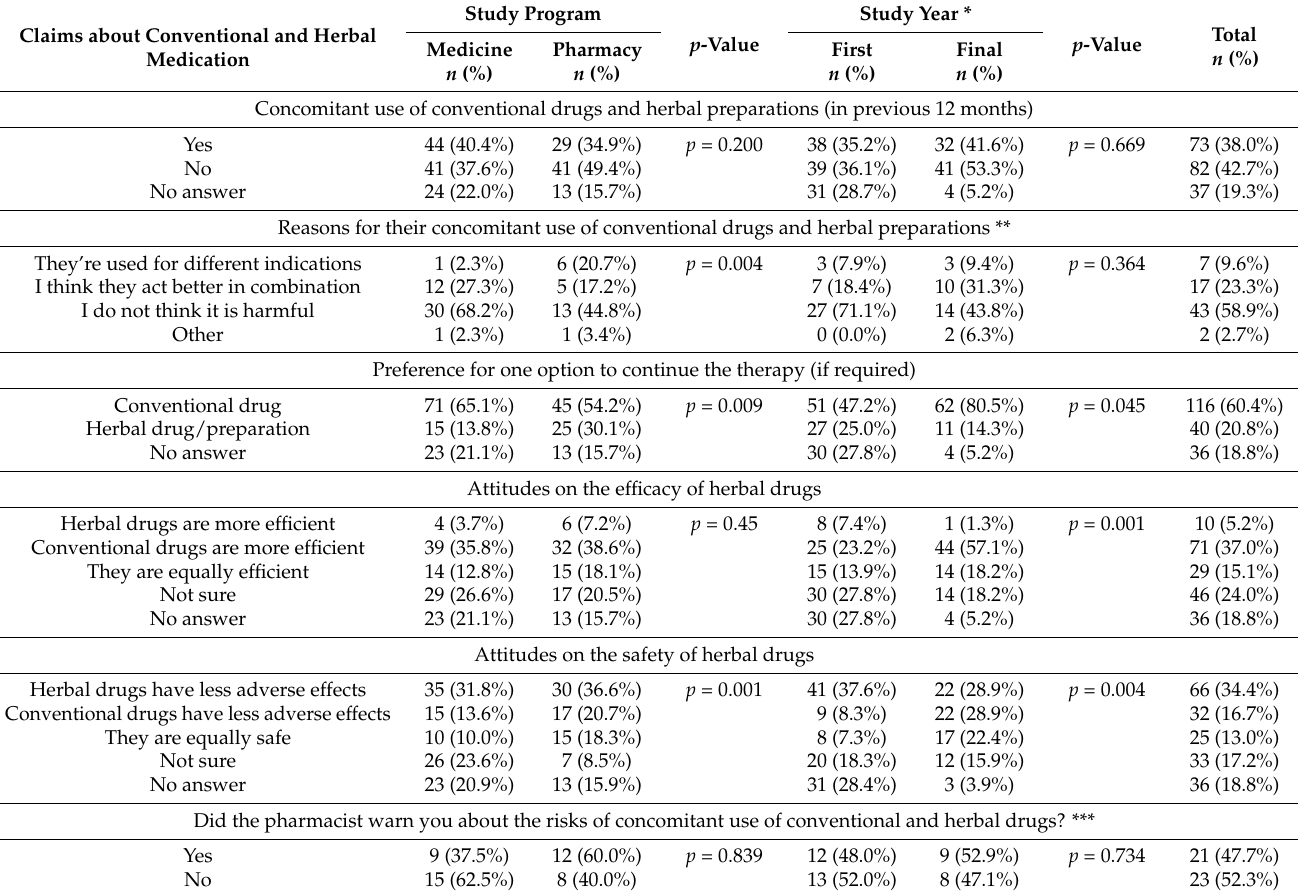
Table 4. Prevalence of self-medication practice with herbal medicines in combination with conven- tional drugs and students’ view about their